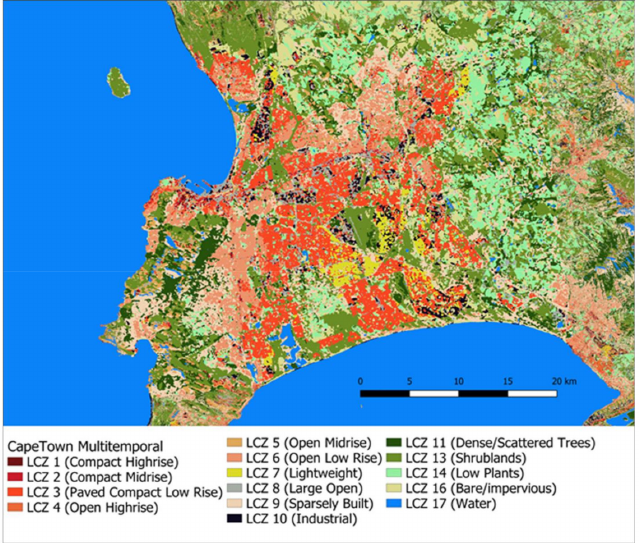
Figure 10. Classification output for Cape Town with a neighborhood function of size